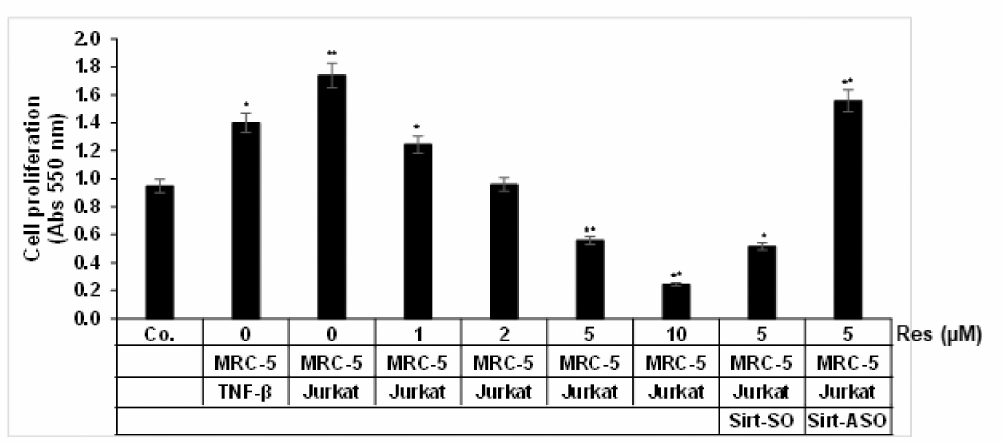
Figure 2. Impact of resveratrol and Sirt1-ASO on colorectal cancer cells (CRC) cell proliferation in the pro-inflammatory multicellular-TME. Serum-starved cultures of HCT116 cells in 3D alginate cultures alone (basal control = co) or co-cultured with fibroblasts and TNF- β (10 ng / mL) (TNF- β -TME) or co-cultured with fibroblasts and T-lymphocytes (pro-inflammatory multicellular-TME) were either left untreated, or multicellular-TME cultures were treated with various doses of resveratrol (Res) (1, 2, 5, 10 µ M), or transfected with 0.5 µ M sense oligonucleotide (SO) control, or antisense oligonucleotides (ASO) against Sirt1 in the presence of Lipofectin transfection reagent (10 µ L / mL) and co-treated with resveratrol (5 µ M) for 14 days in alginate cultures, and cell viability was measured using the MTT method, as described in the Materials and Methods section. All assays were performed at least three times. * p < 0.05, ** p < 0.01 relative to basal